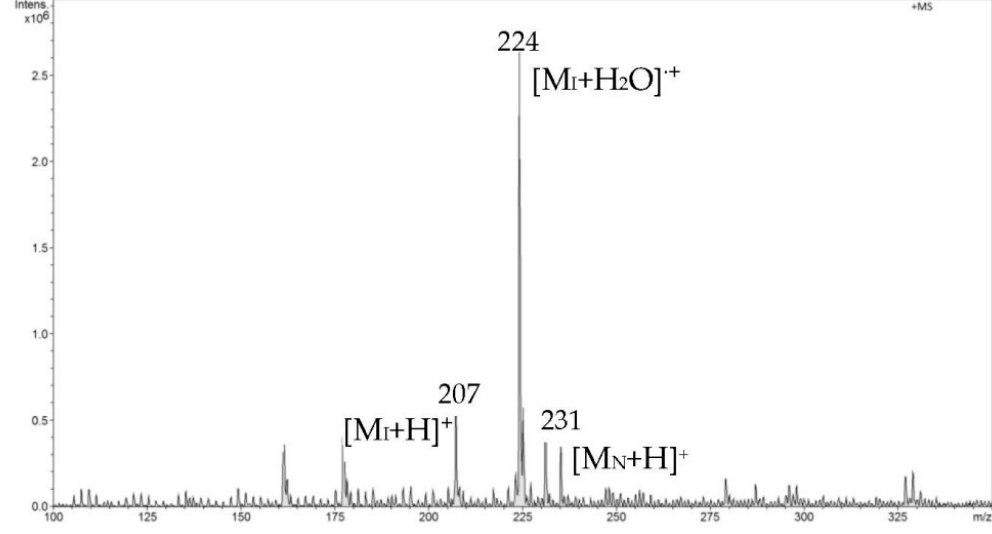
Figure 9. FAPA ‐ MS spectrum recorded in the initial heating phase from 20 °C to 120 °C.